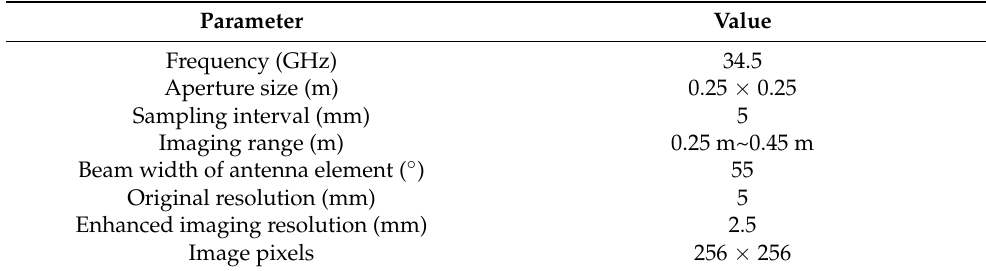
Table 1. Parameters for generating simulated data.